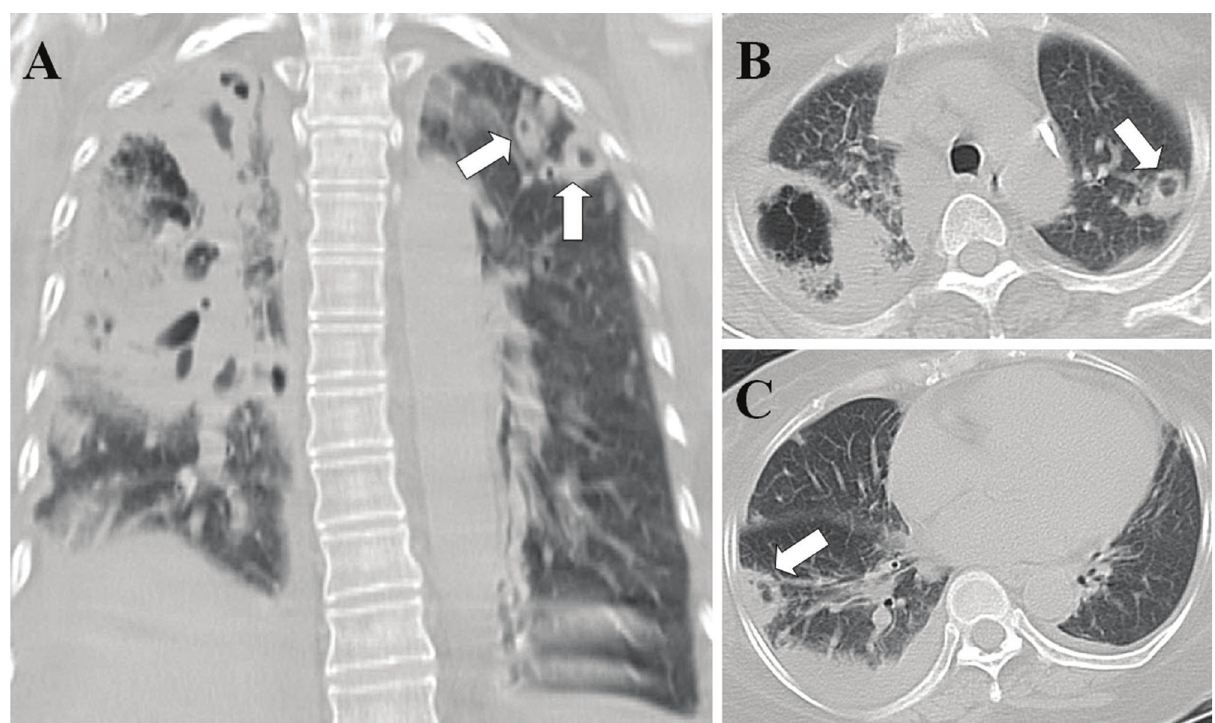
Figure 2 - Necrotizing pneumonia with septic pulmonary emboli. (A) A lung window of a coronal-sectional CT scan shows necrotizing pneumonia in the right lung. Multiple different sizes of nodules with cavities in the left upper lobe (arrows), suggestive of septic pulmonary emboli, are observed. (B) A lung window of a cross-sectional CT scan shows necrotizing pneumonia in the right upper lobe and a cavitary nodule in the left upper lobe (arrows). (C) A peripheral wedge-shaped opacity abutting the adjacent pleura in the right lower lobe (arrow) and pleural effusion are seen. The patient was a 62-year-old diabetic woman whose blood and sputum cultures were positive for methicillin-resistant Staphylococcus aureus